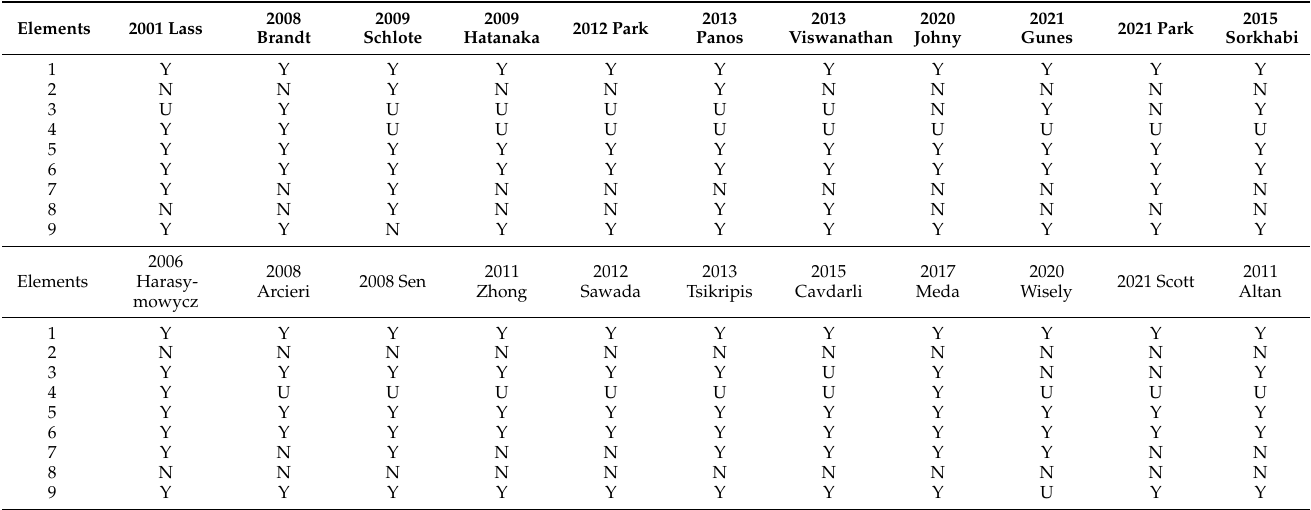
Table A4. The result of methodological quality assessment by McHarm tool.